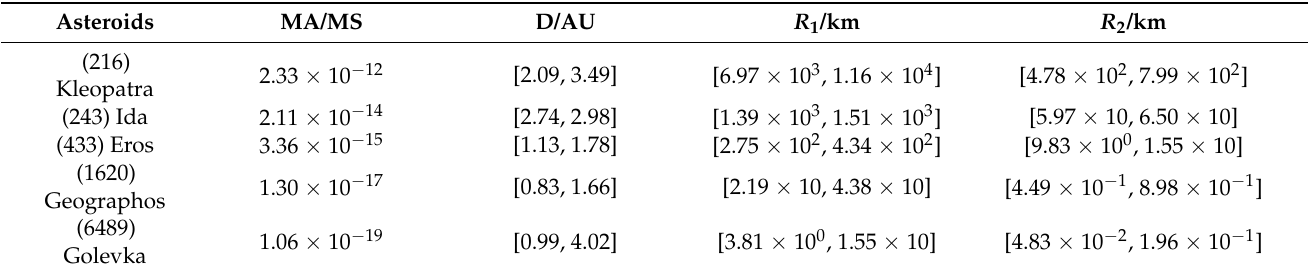
Table 4. Gravitational radius of